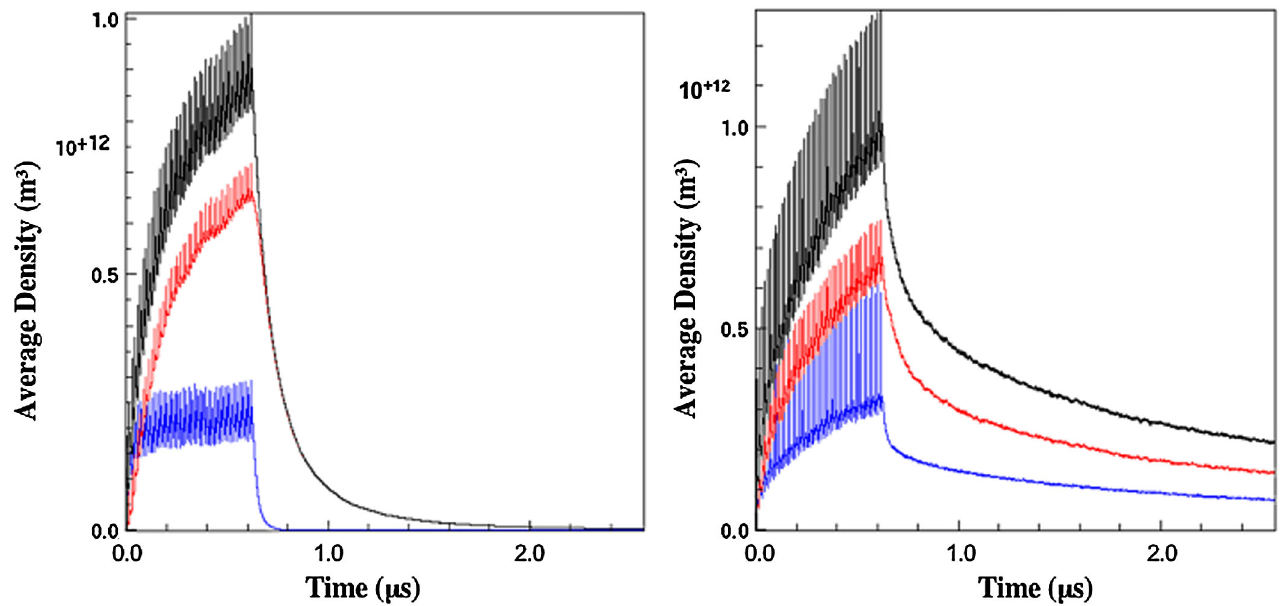
FIG. 9. Buildup and decay of electron density vs time for z within 3.134 mm of the maximum of B y in the wiggler (left) and z at ¼ 0 (right) for a 45-bunch train. In each case the bottom curve is photoelectrons, middle curve is secondary electrons, and top curve B y is the